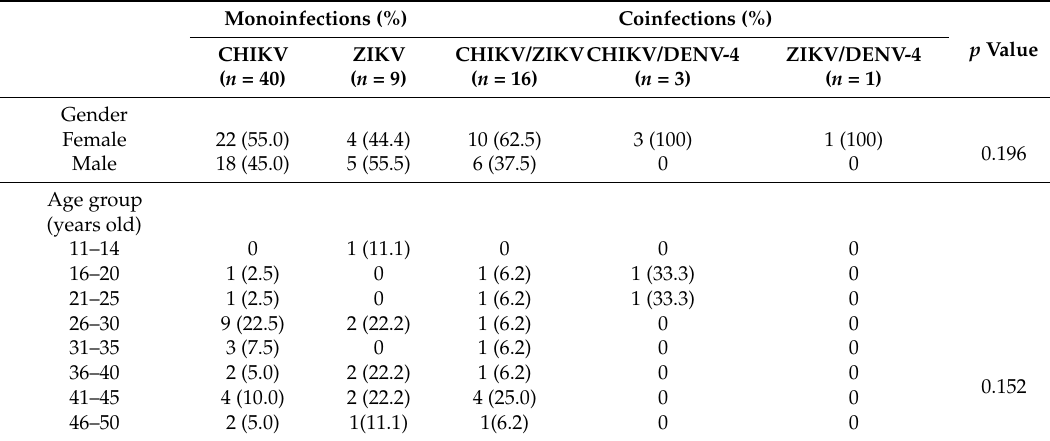
Table 3. Clinical, and demographic distribution of CHIKV and ZIKV monoinfections and